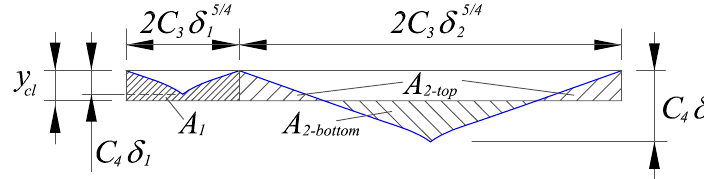
Figure 7. Profile of the grooves generated in the UVAG of